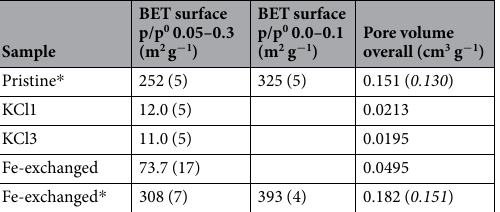
Table 3. Results of N 2 adsorption analyses. In italics, in parenthesis, volume of micropores. Data of the pristine sample were taken from ref. 23. KCl1 and KCl3 refer to fibres subjected to, respectively, 1 and 3 KCl treatments (see Materials and Methods for details). Note: * Sample pre-treated at 65 °C for 15 hour and then at 200 °C for 2 hours.